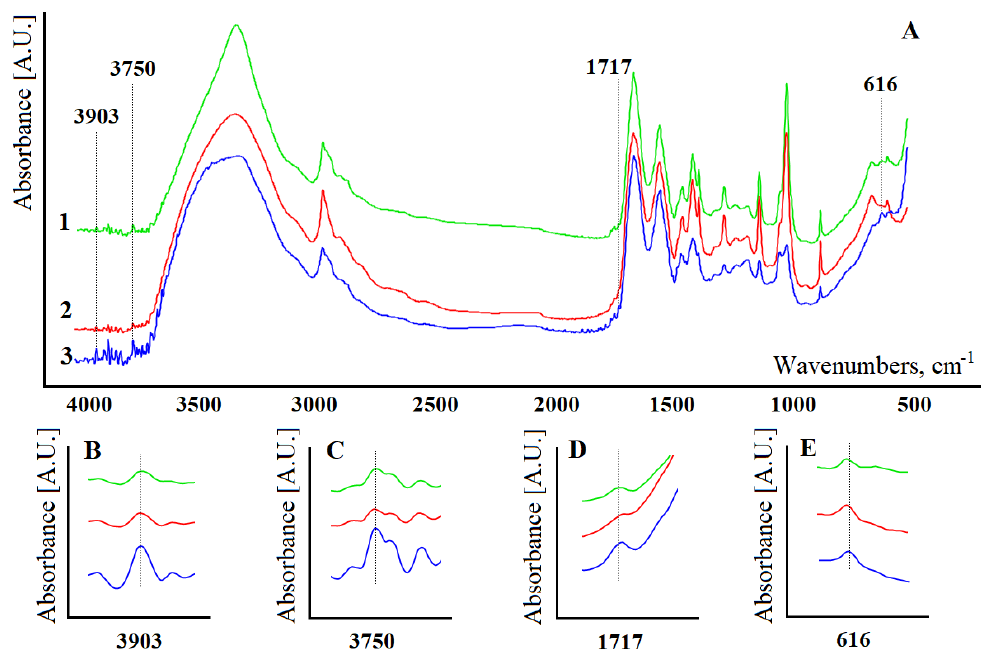
Figure 2. FTIR spectra of the model solutions when the stock solution is diluted 5 times (curve 1), 3 times (curve 2), and 2 times (curve 3), respectively ( A ). Enlarged portions of FTIR spectra for 3903 cm − 1 ( B ), 3750 cm − 1 ( C ), 1717 cm − 1 ( D ) and 616 cm − 1 ( E ).